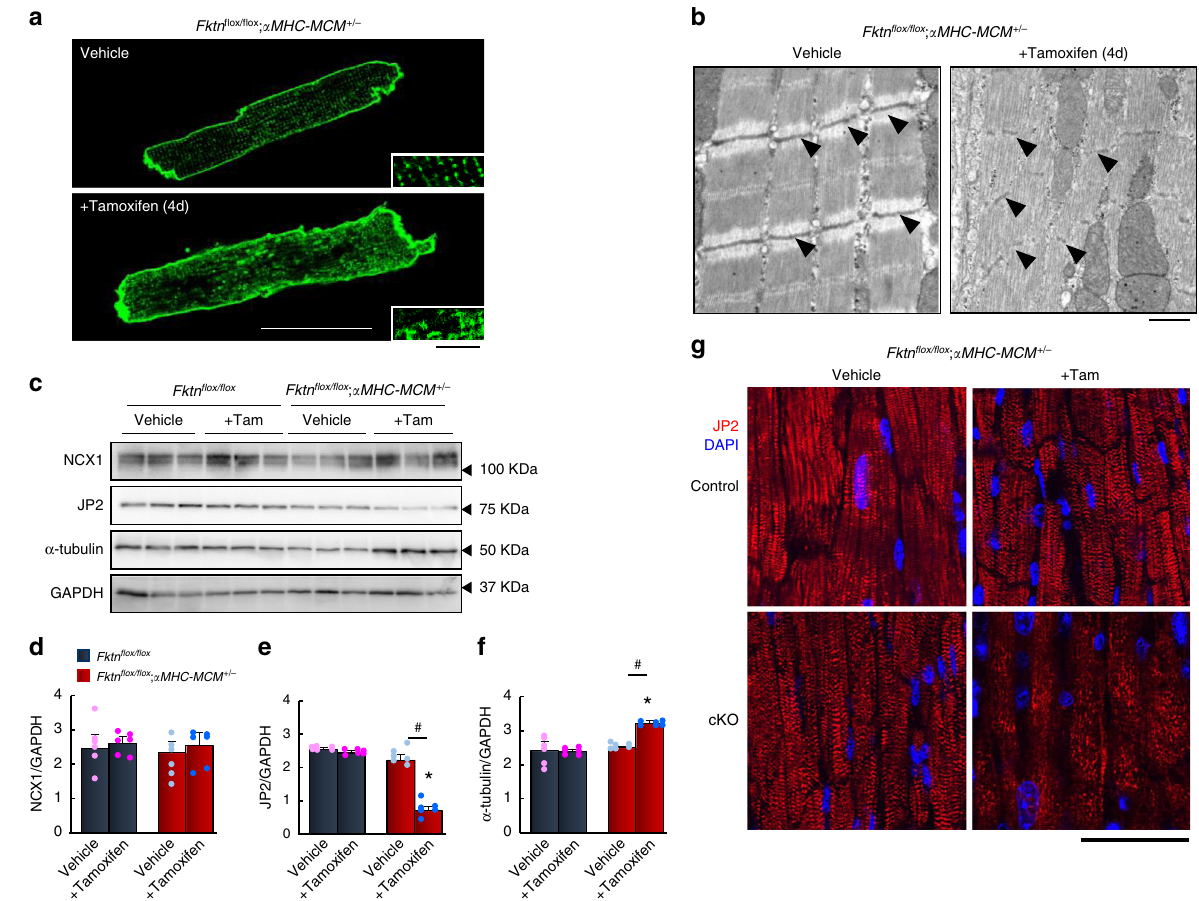
Fig. 7 Subcellular change in α MHC-MCM- Fktn -cKO ( Fktn fl ox/ fl ox ; α MHC-MCM + / − ) myocytes. a Representative membrane staining by di-8-ANEPPS. Scale bar, 50 μ m (inset, 10 μ m). b Representative electron micrographs of myo fi laments in vehicle- and tamoxifen-treated α MHC-MCM- Fktn -cKO mice. Arrowheads show Z-lines. Scale bar, 1 μ m. Representative immunoblots ( c ) and expression levels ( d – f ) for NCX1, JP2, and α -tubulin in fl oxed (control) and α MHC-MCM- Fktn -cKO mice with or without tamoxifen. GAPDH was used as a loading control ( n = 6 mice per group). * P <0.05 vs. vehicle-treated fl oxed mice; # P <0.05 between indicated groups based on Tukey – Kramer tests. g Representative immunostaining for JP2 (red) and DAPI (blue). Scale bar, 50 μ